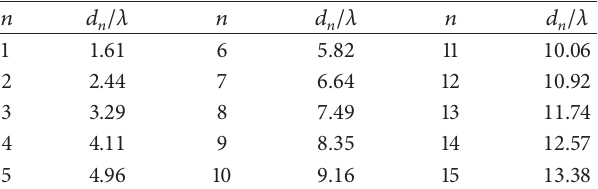
Table 4: Locations for the reweighted design example.